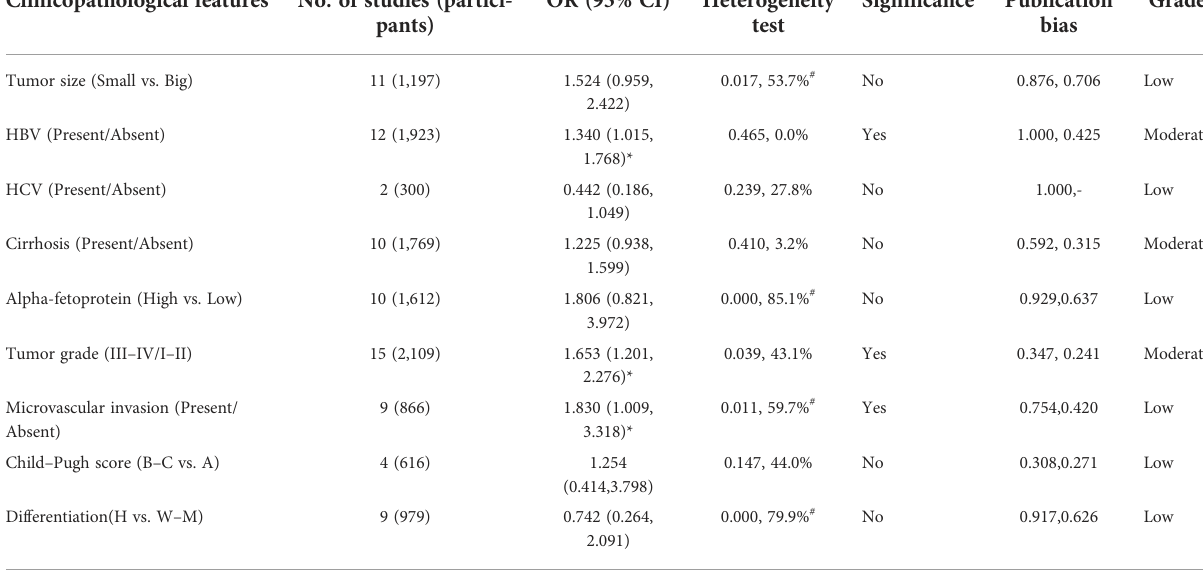
TABLE 3 Summarized of association between high GPC-3 expression and clinicopathological features in prognosis of patients with hepatocellular carcinoma from low GPC-3 expression. Clinicopathological